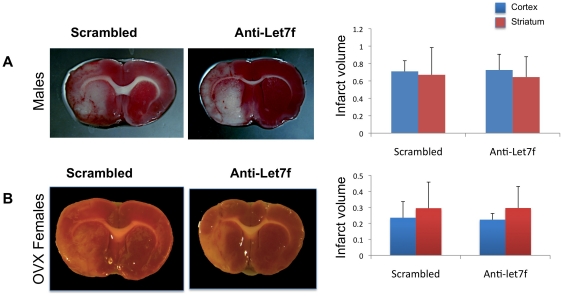
Sex difference in anti-Let7f treatment on infarct volume.A. Male rats received ICV injections of anti-Let7f 4 h post MCAo. Infarct volumes assessed using TTC stained brain sections indicated that anti-Let7f treatment had no effect on the severity of cortical or striatal infarction. B. Ovariectomized female rats received ICV injections of anti-Let7f 4 h post MCAo. Infarct volumes assessed using TTC-stained brain sections indicated that anti-Let7f treatment had no effect on cortical or striatal infarction. Histograms depict mean ± SEM, n = 4–6 per group.